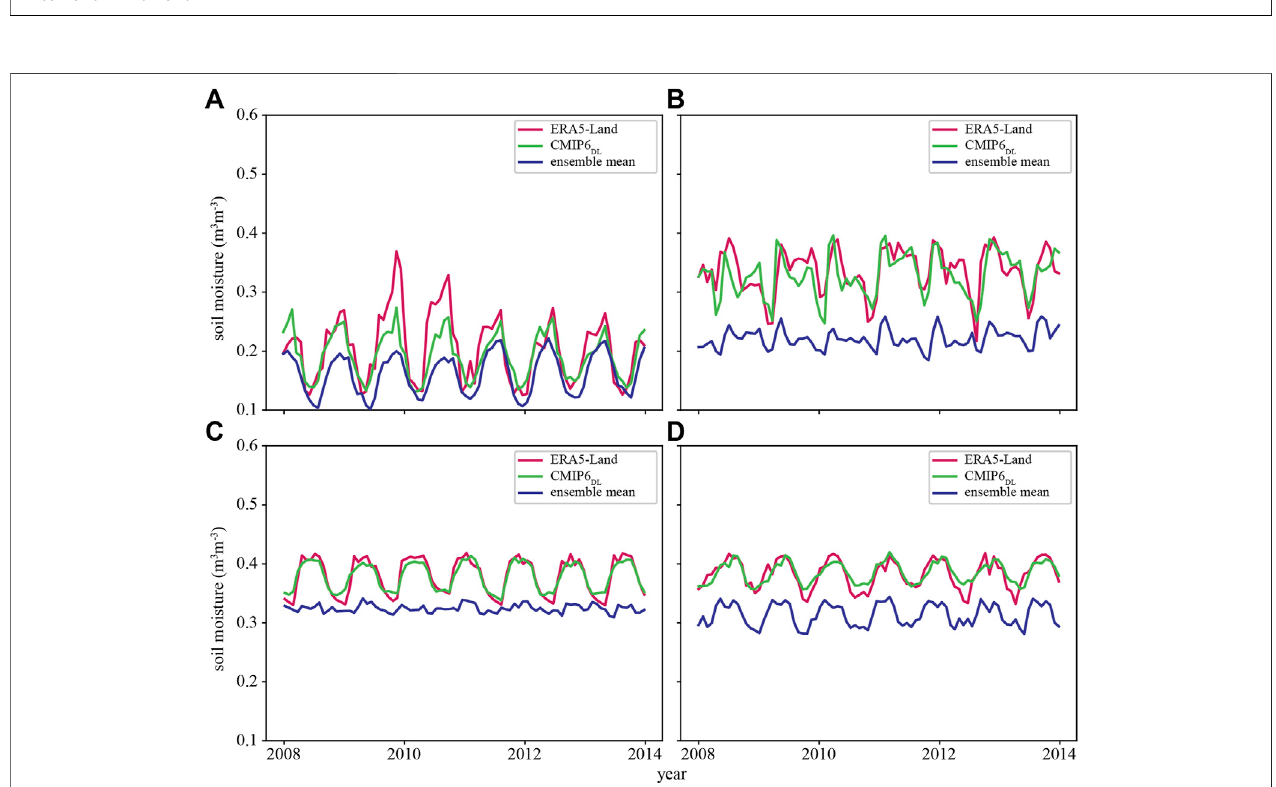
FIGURE 4 | Time series of the SSM; each grid is selected from different climatic zoning from 2008 to 2014 for CMIP6 DL . The coordinates of the four grids are (A) 84.5 ° E, 44.75 ° N (arid zone) (B) 113.75 ° E, 39 ° N (semiarid-subhumid zone) (C) 94 ° E, 30.25 ° N (Tibetan-Plateau) (D) 102.25 ° E, 29.75 ° N (humid zone).